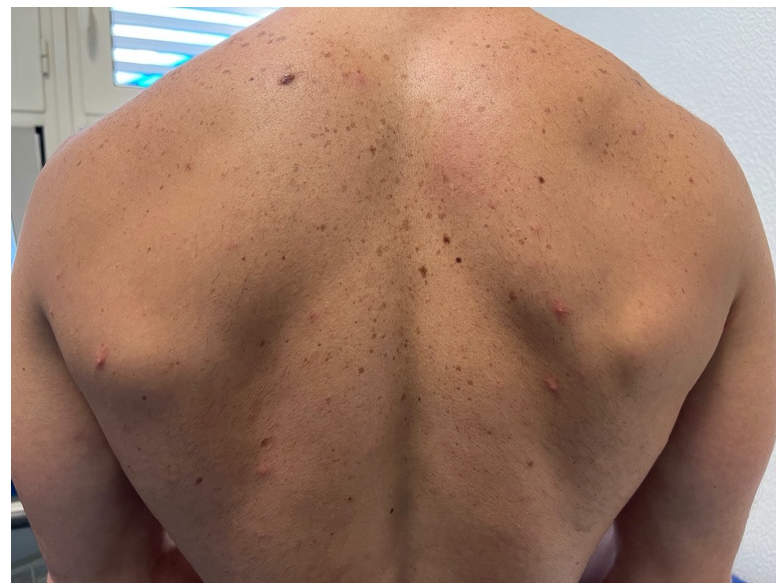
Figure 1. Example of MPX papules in the trunk.